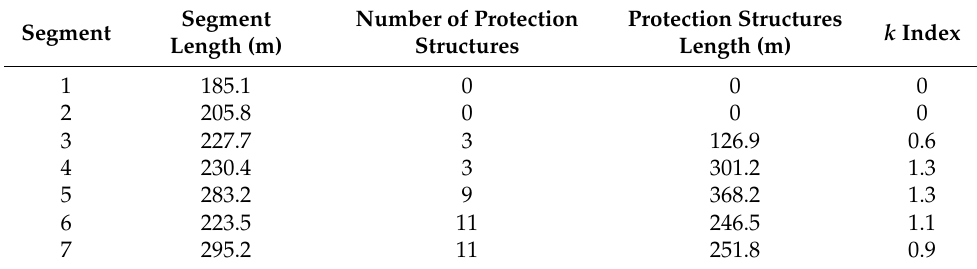
Table 3. Values of the k index in each segment